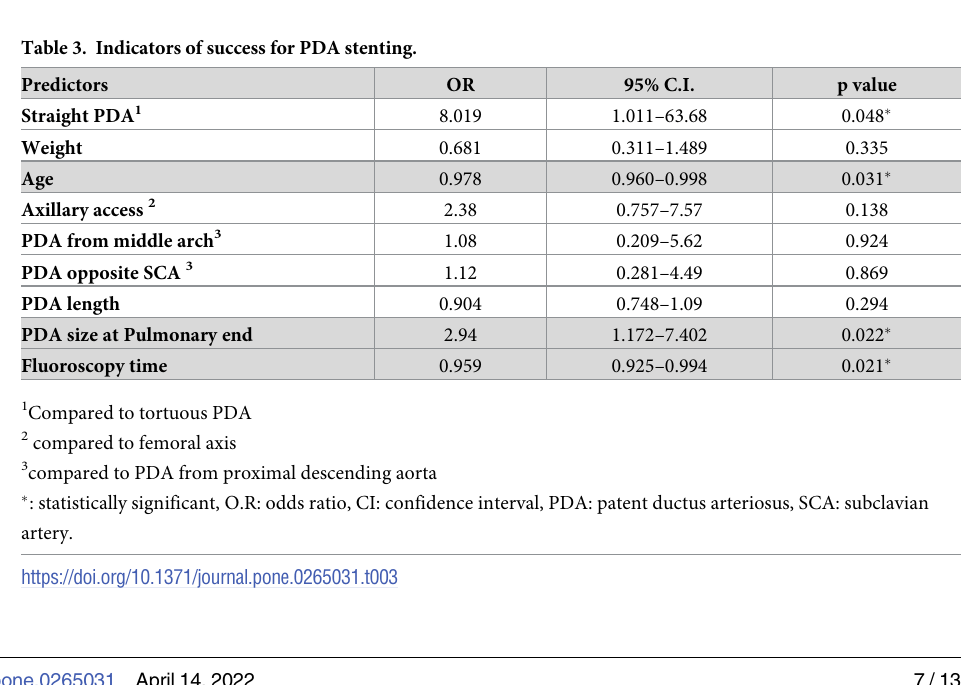
RPA: right pulmonary artery, LPA left pulmonary artery, PDA: patent ductus arteriosus.